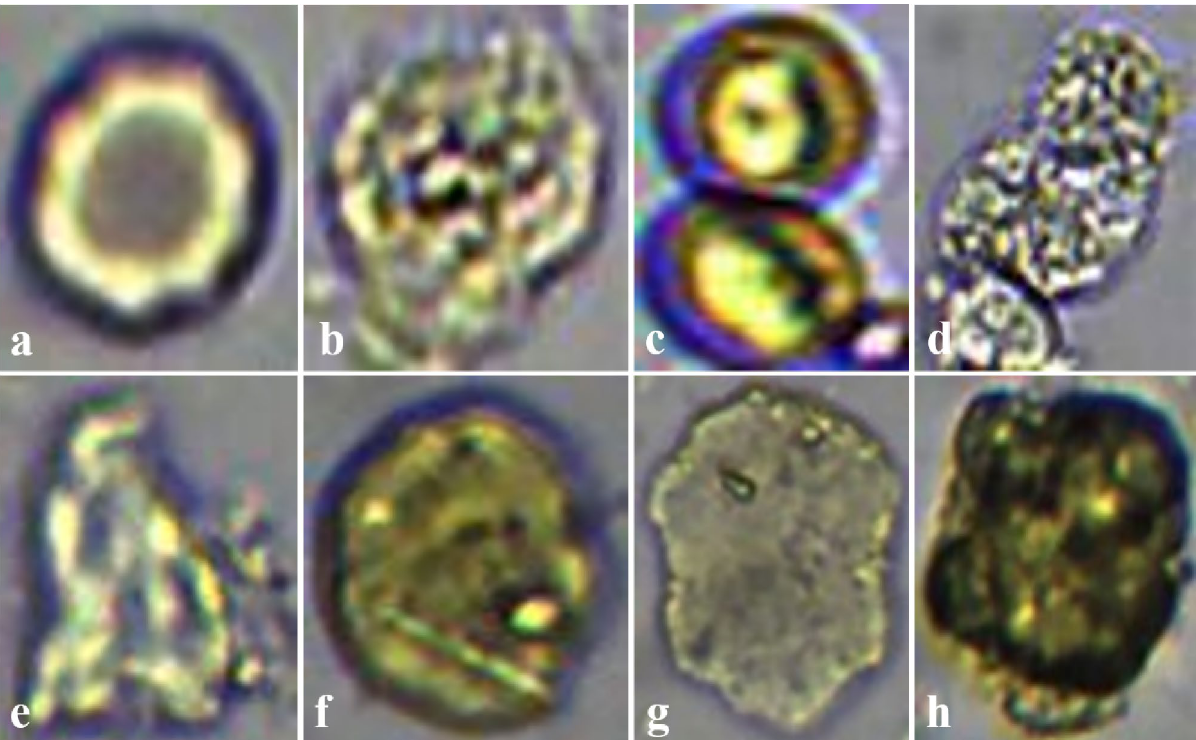
Figure 1. Cells and impurities in fecal samples. ( a ) RBC, first layer with a black outer cycle, second layer with a highlighted irregular cycle, inner with brown cycle; ( b ) WBC, generally round, with noise like the texture inside; ( c ) Mid, budding mold is generally composed of multiple spherical joints; ( d ) PYO, usually formed by adhesion of multiple leukocytes; ( e , f ) are different impurities; ( h )